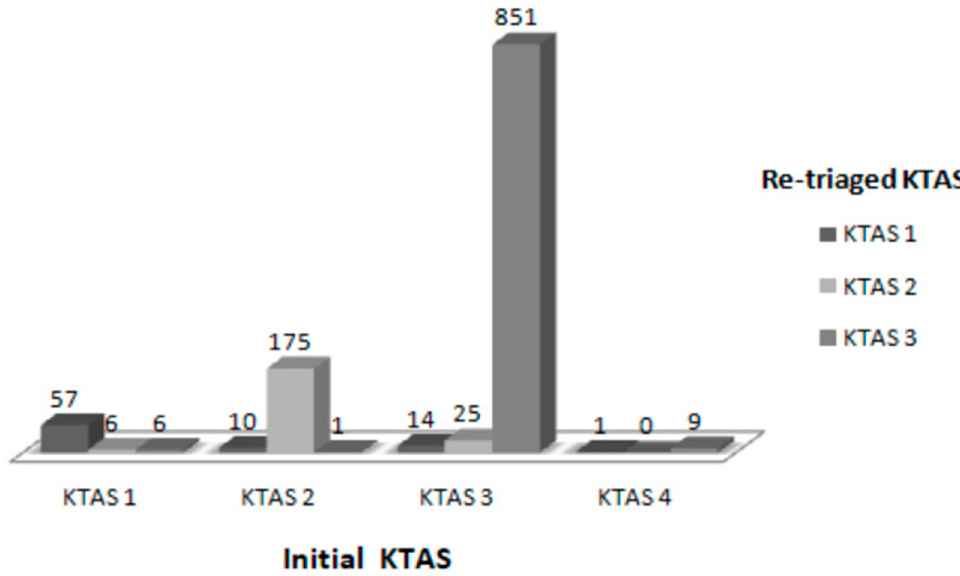
Figure 2. The initial Korean Triage and Acuity Scale (KTAS) and re-triaged KTAS findings.